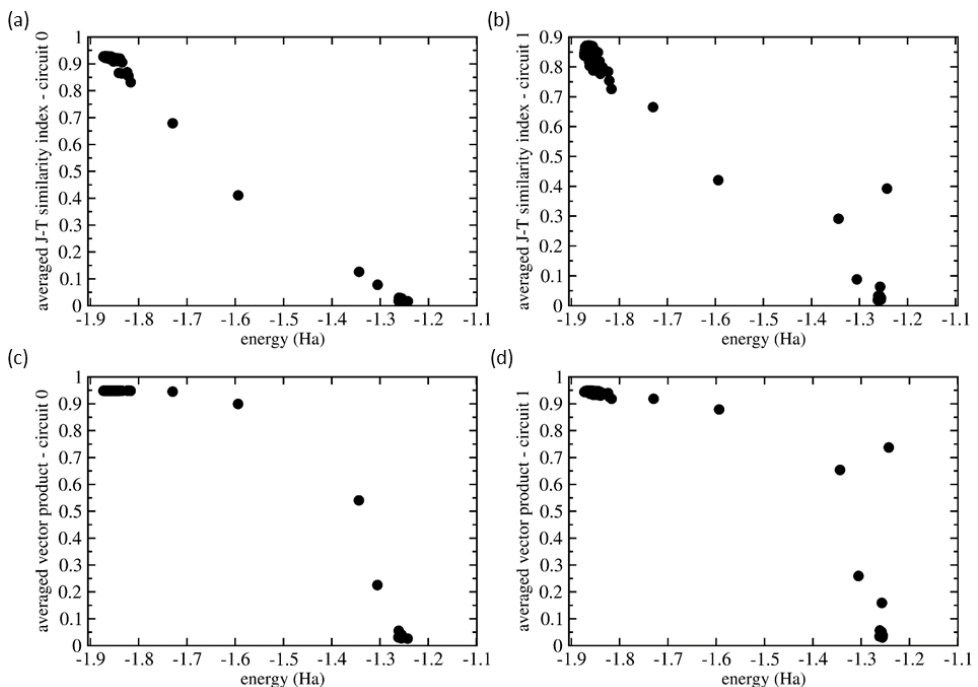
Figure A2. Comparison of similarities of vectors of measured probabilities as functions of energies. The plotted values are averaged ones using all 200 values and evaluated using either the Jaccard- Tanimoto (J-T) similarity index (parts ( a , b )) and scalar product (parts ( c , d )) for both the circuit 0 (parts ( a , c )) and circuit 1 (parts ( b , d